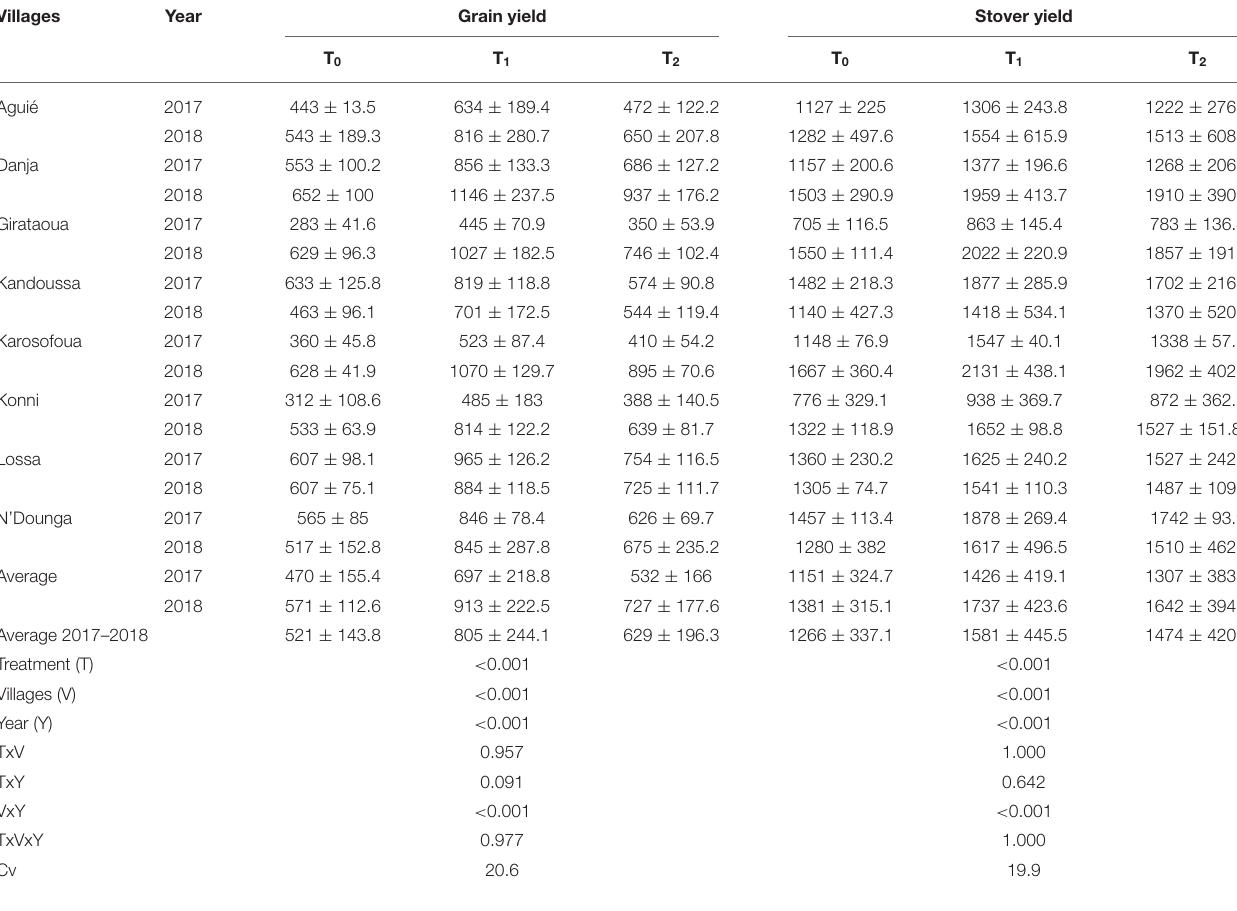
TABLE 6 | Effect of the treatments on grain and stover yield (kg ha − 1 ) in farm experiments during two calendar years (standard error in parenthesis). Villages Year Grain yield Stover